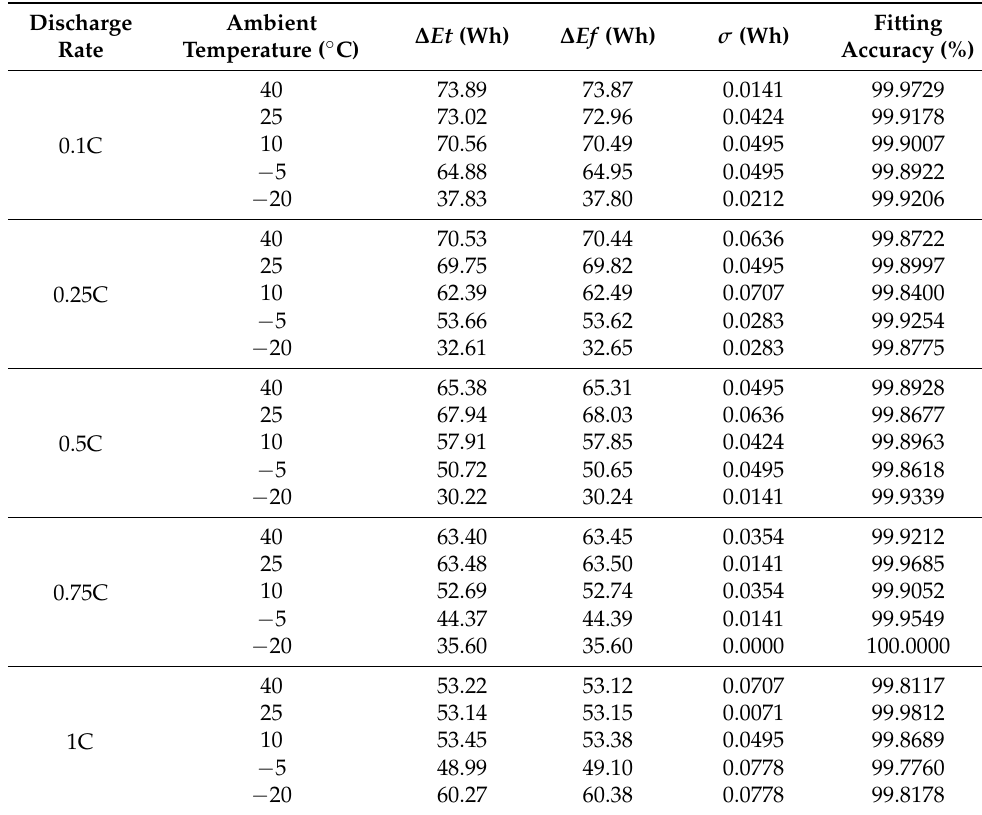
Table 3. Comparison of discharge energy in voltage plateau